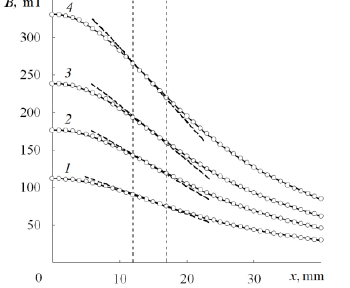
Fig.4. The characteristics of the Fig.3. The characteristics of the field induction at induction gradient (by data of Fig. the symmetry plane of region between the pole 3); dashed and solid lines – are the pieces shaped as hemispheres 100 mm in diameter calculation by using equation (4), with the distance between them is 10 mm for which is written for polynomial (3) different values of the winding current I : 1 - I =4A, 2 of 5th and 4th degree – I= 8A, 3 – I = 16 А , 4 – I = 40 А ; the dots are the experimental results, the lines present the results of calculation by (3)